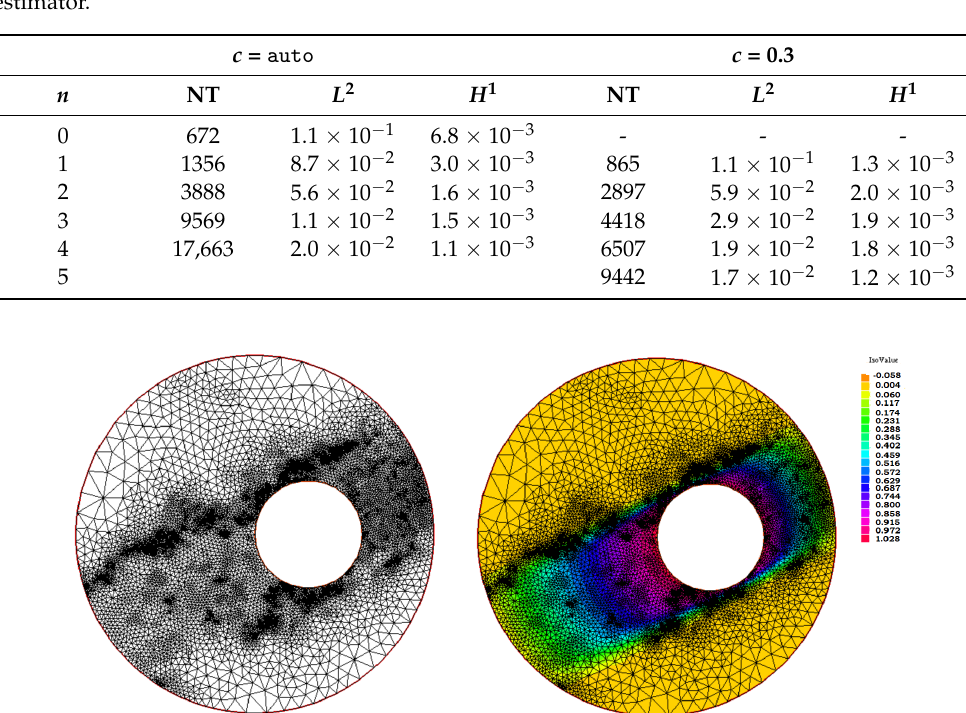
Table 8. Error in L 2 norm and H 1 seminorm for example 3 obtained with the gradient recovery error estimator.